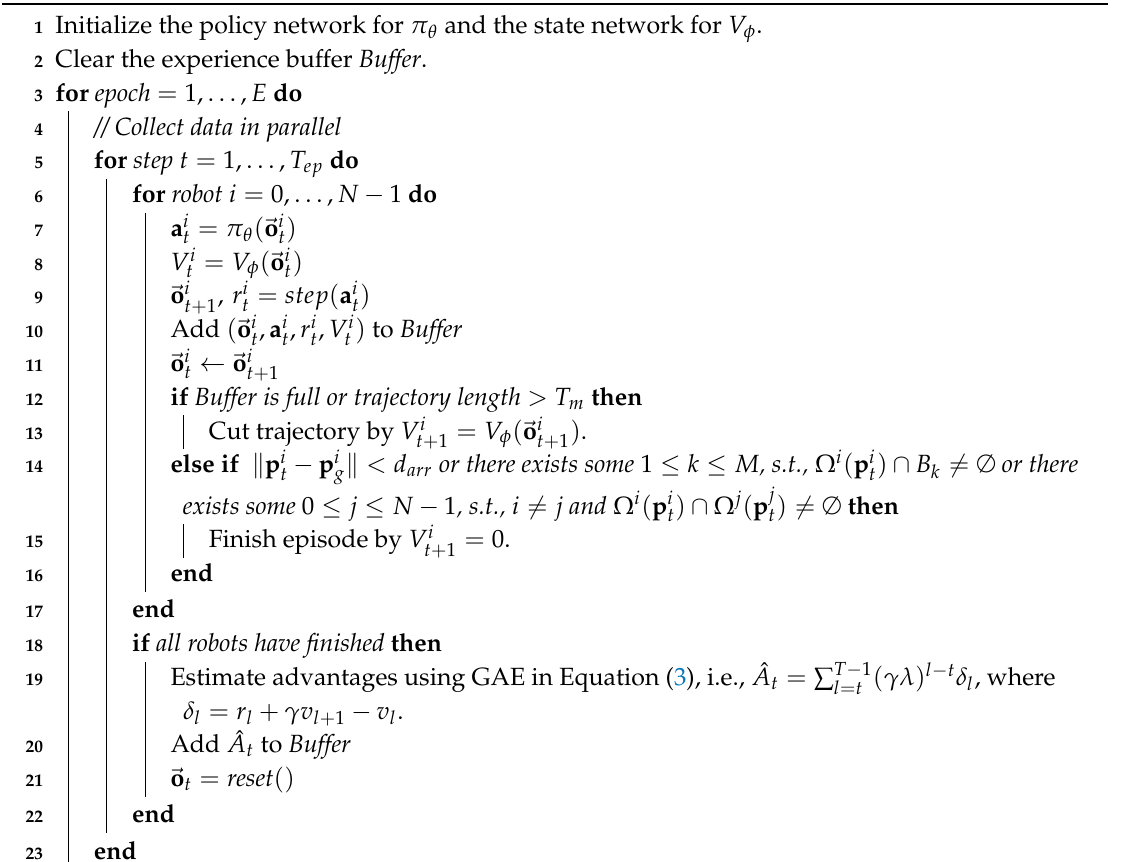
Algorithm 1: Distributed Proximal Policy